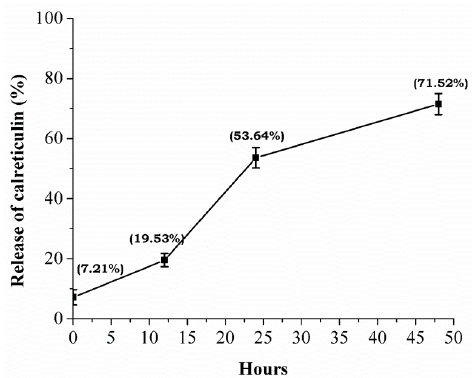
Figure 4. Release of calreticulin. Measurement of calreticulin release by ELISA test show an accumulative release of the protein present in the nanocomposite until 48 h.